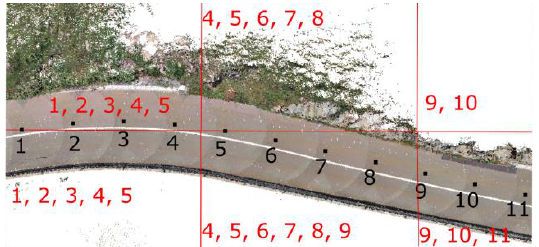
Figure 4. Tiles association. Trajectory points in black. Tiles assignation in red.